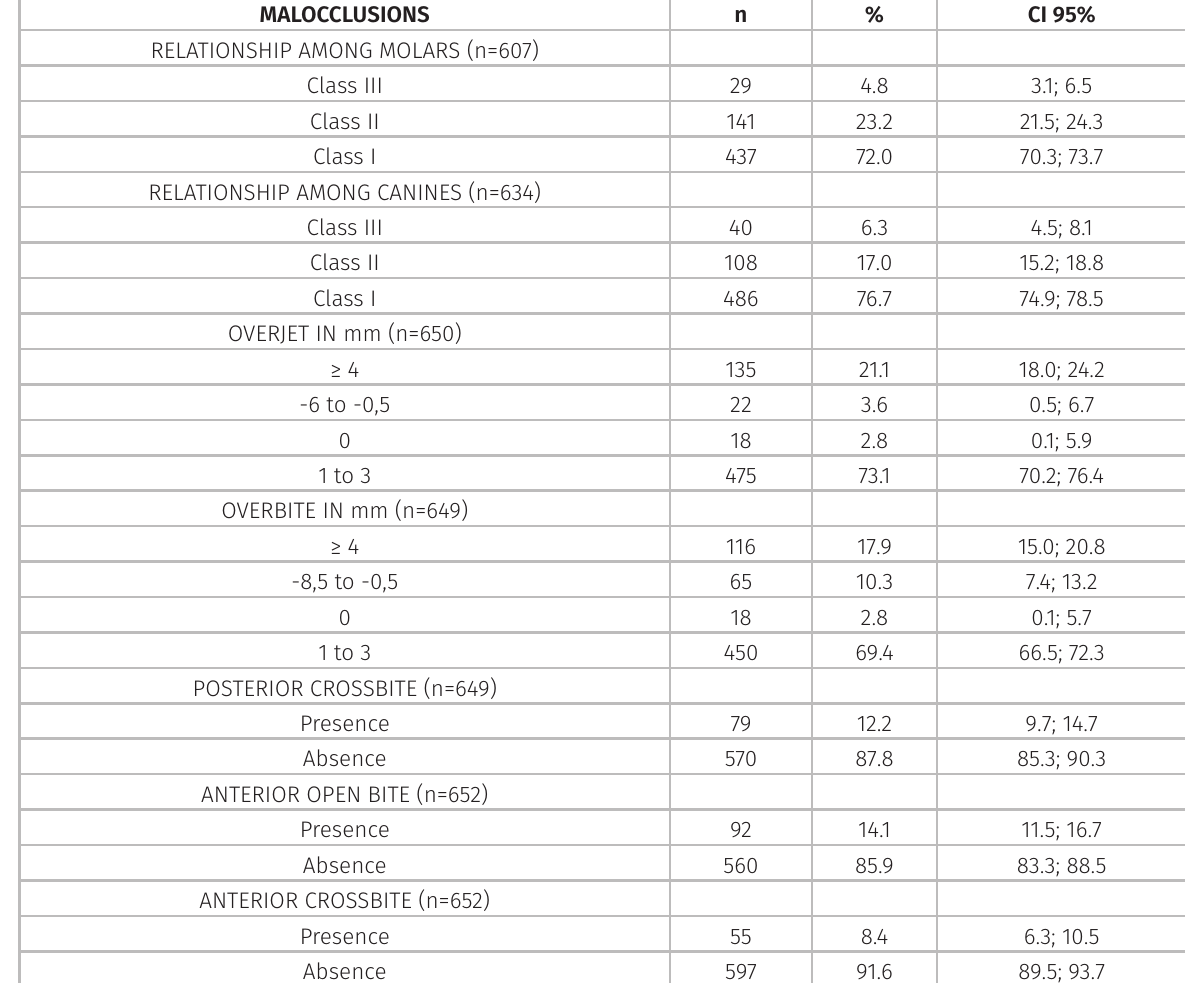
Table III. Prevalence of malocclusions in the mixed dentition among 6-years-old schoolchildren. Palhoça/SC,